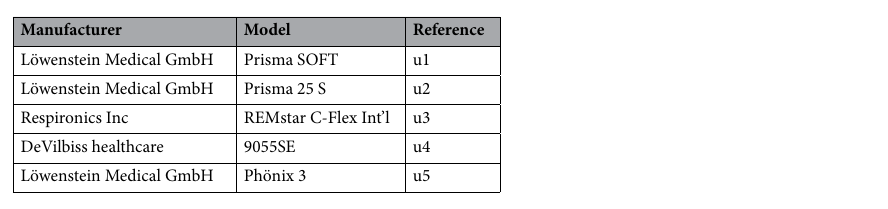
Table 3. List of CPAP machine